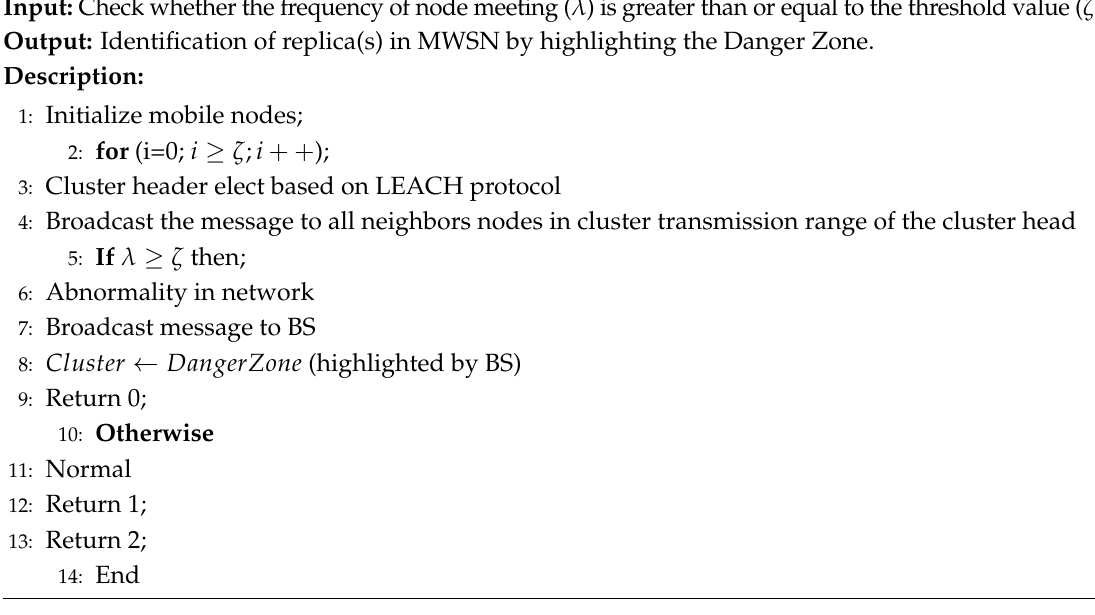
Algorithm 1 Cluster Based (First Level